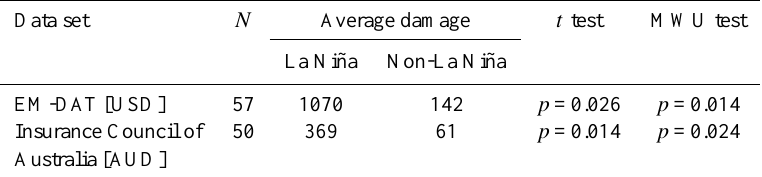
Table 2. Average economic flood losses in Australia stratified according to ENSO phase. Analysis based on data from EM-DAT (CRED, Belgium) for 1971–2010, and insured loss data normalized for changes in wealth from the Insurance Council of Australia for 1967–2010 (for method, see Crompton et al., 2008). The t test and Mann–Whitney U test (MWU test) were applied indicating the significance of the differences in average